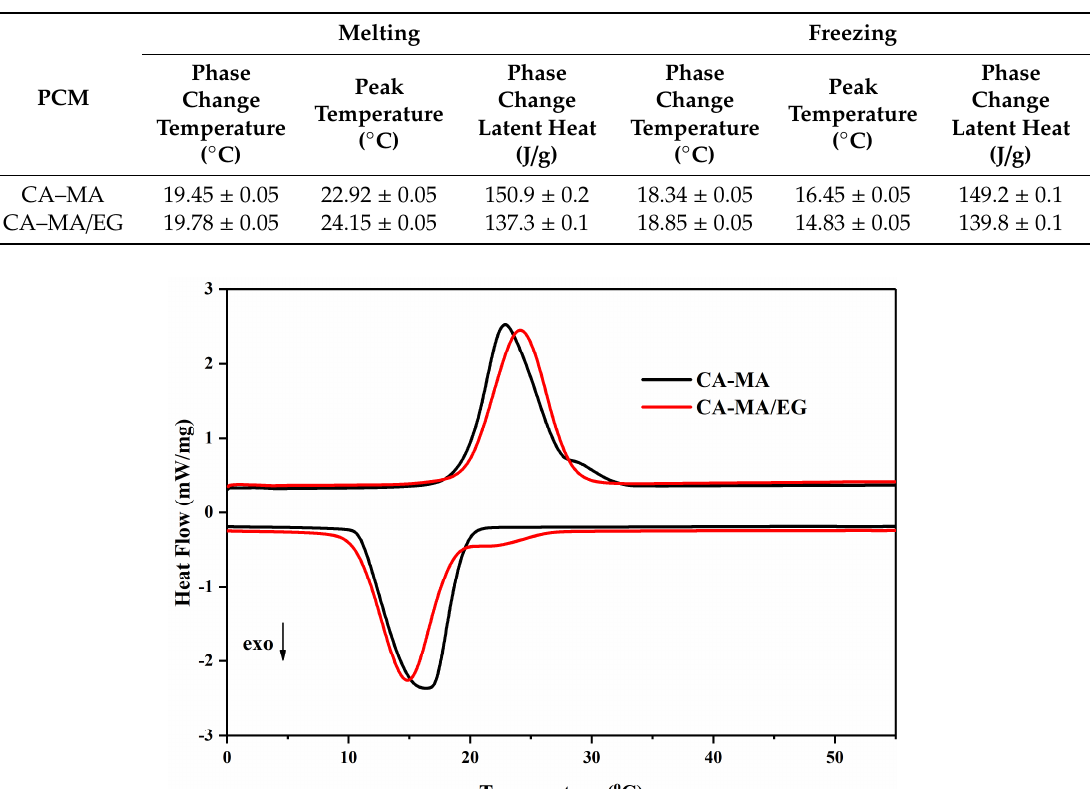
Table 2. Heat performances of CA–MA and CA–MA / EG.